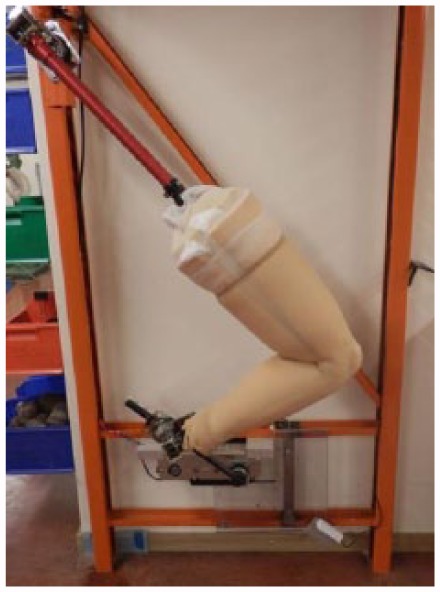
Durability test rig.